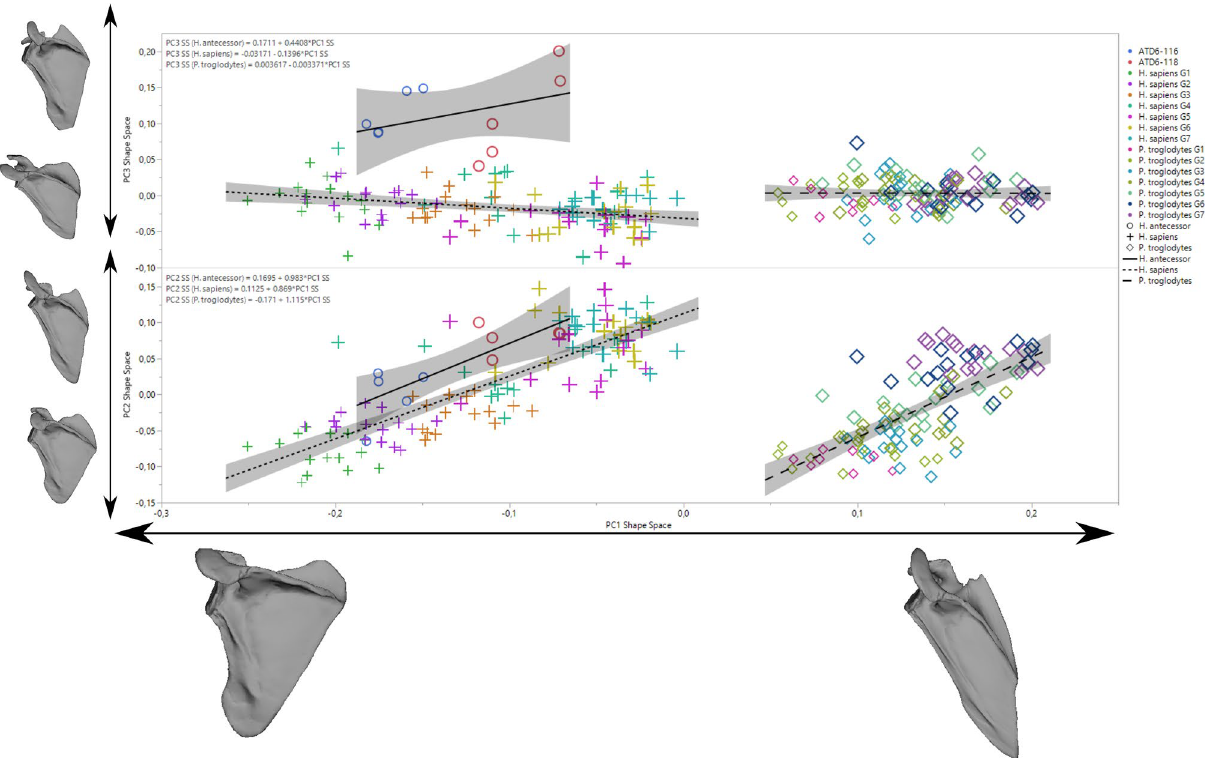
Figure 6. Shape space PCA showing ontogenetic trajectories for H. sapiens (“+” symbols), P. troglodytes (“diamond” symbols), and H. antecessor (“circle” symbols). The regression formula and the confidence intervals are shown. Notice that for H. antecessor, all the acromion estimations are depicted (see “Materials and methods”). Different colors depict different age